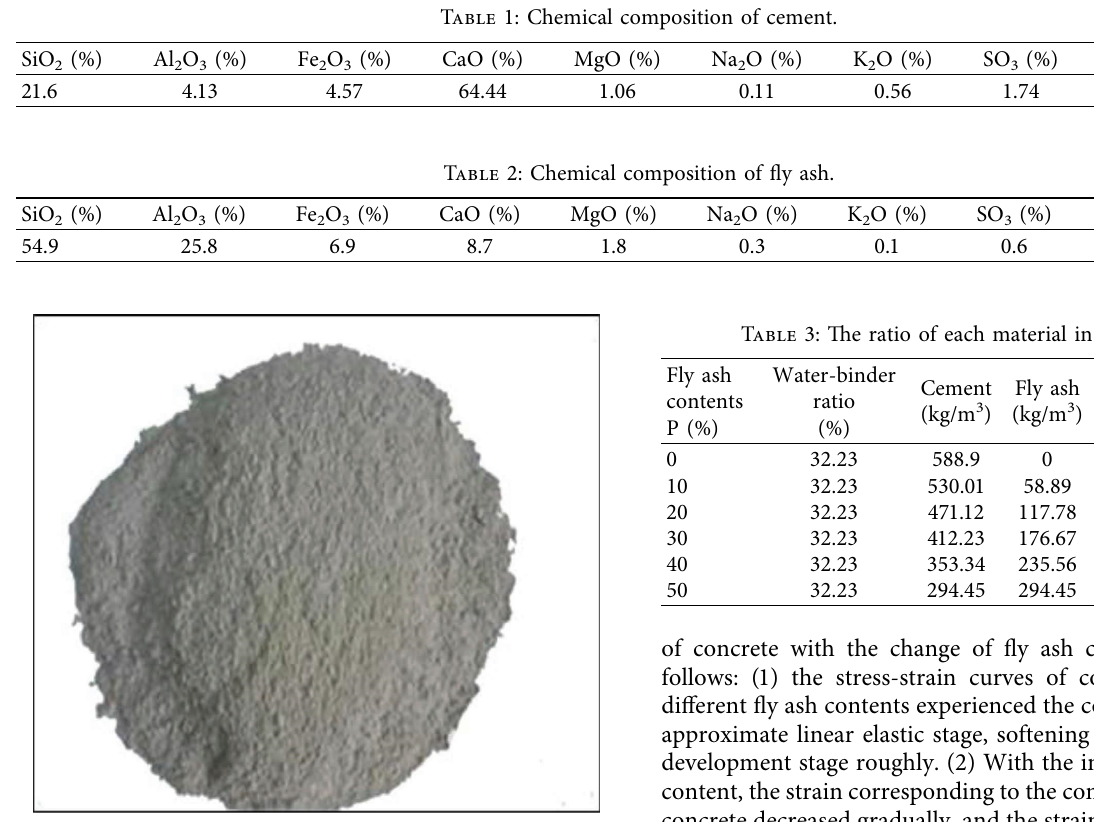
Figure 1: Fly ash ingredient.